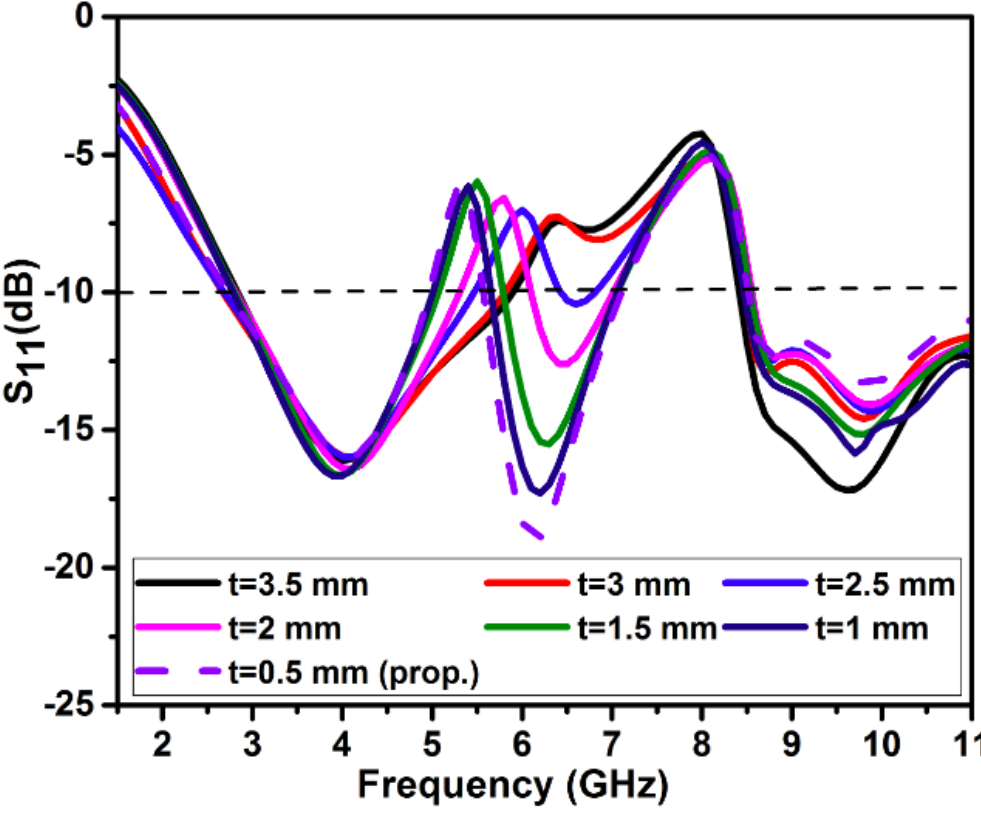
Figure 7. S 11 for variation of width ‘t’.